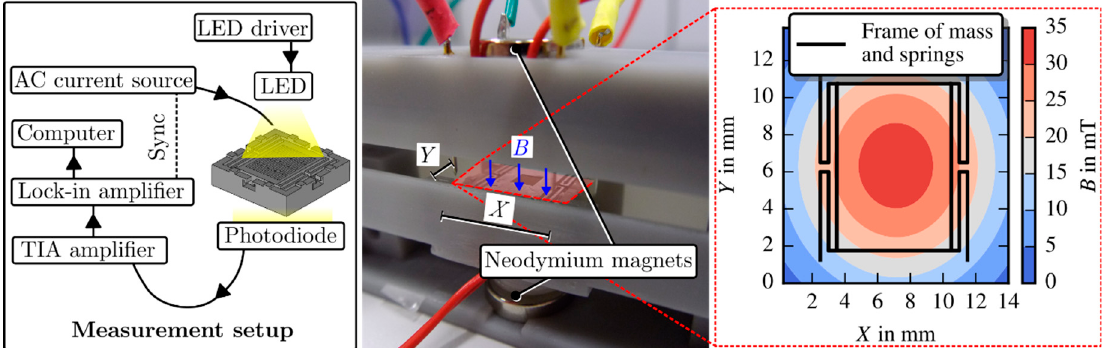
Figure 3. Schematic configuration of the measurement setup on the left. The image in the middle depicts a prototype arranged in between two neodymium disc magnets and partly opened mounting device. The red area indicates the associated distribution of the magnetic flux density, characterised with a Hall effect sensor.